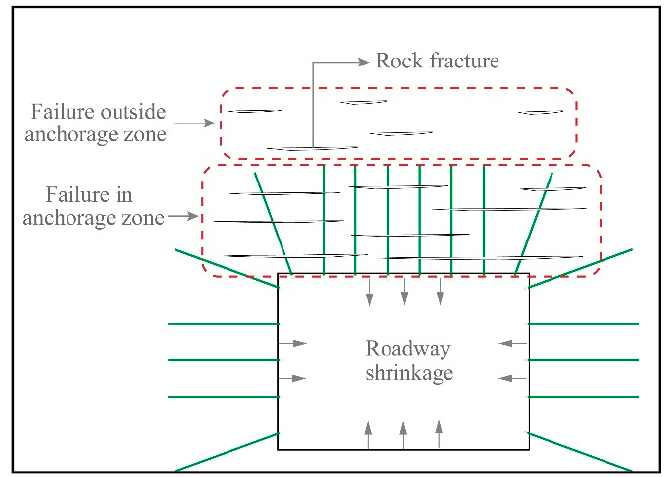
Figure 11. Crack expansion of short bolt support.